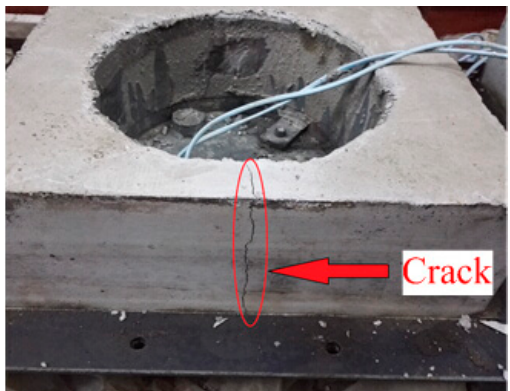
Figure 7. Cracking location of RSERST specimen.